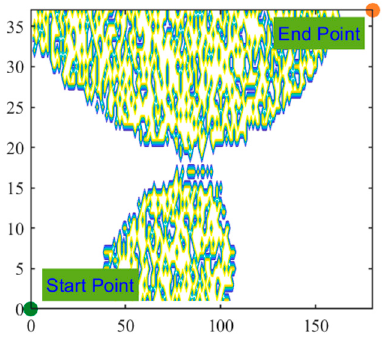
Figure 21. Binary map of case 1.